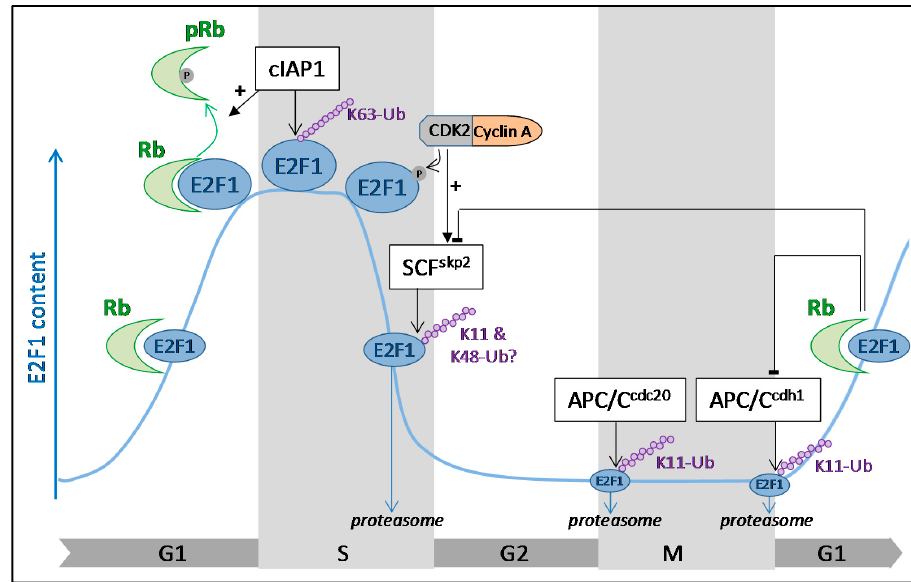
Figure 1. Cell cycle regulation of E2F1 (E2 promotor binding factor 1) by ubiquitination. The E2F1 cellular content fluctuates along the cell cycle. It progressively increases in G1, peaks in S phase to promote the expression of genes required for the S-phase transition, then declines as cells progress through the S phase of the cell cycle. In G1, Rb (retinoblastoma) binds to E2F1 and represses its transcriptional activity. Sequestration of E2F1 by Rb stabilizes the protein and allows its accumulation during the G1 phase. The stability of E2F1 is controlled by ubiquitination throughout the cell cycle. In S phase, E2F1 is conjugated with K63-linked ubiquitin chains in a cIAP1 (cellular inhibitor of apoptosis 1)-dependent manner, contributing to its stabilization. At the end of the S phase, phosphorylation of E2F1 by CDK2 (cyclin-dependent kinase 2)/cyclin A complex is a signal for SCF (S-phase kinase-associated protein 1-cullinnn1-F-box) skp2 -mediated ubiquitination that targets E2F1 for proteasomal degradation. In the G2, M, and early G1 phases of the cell cycle, E2F1 content is maintained at low levels thanks to APC/C (anaphase promoting complex/cyclosome) cdc20 and APC/C cdh1 -mediated ubiquitination and proteasomal degradation.